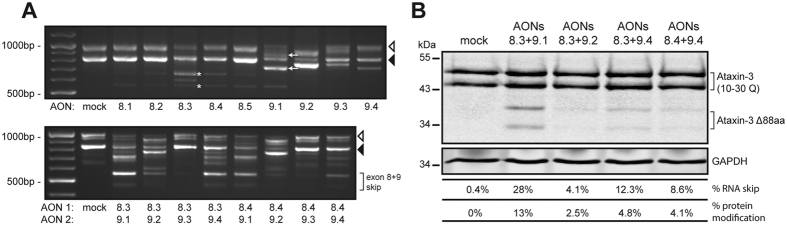
Ataxin-3 exon skipping in human fibroblasts.Control and SCA3 patient derived human fibroblasts were transfected with AONs complementary to exon 8 or 9 of ATXN3. (A) Screening of individual AONs for exon skipping activity at RNA level in SCA3 derived fibroblasts (white arrowhead = ATXN3 71 CAG, black arrowhead = ATXN3 10 CAG). For both the mutant and wild-type allele, the PCR product representing the single exon 8 skip is indicated with an asterix. Single exon 9 skip is indicated with an arrow. Combination of AONs for exon 8 and 9 were tested for simultaneous exon skipping (lower panel). (B) AON induced ataxin-3 protein modification. The most optimal AONs identified by the RNA screening were transfected in control fibroblasts and subjected to western blot analysis and anti-ataxin-3 probing. Percentage of exon skipping on RNA level as determined by qPCR and corresponding percentage of modification on protein level are indicated below.